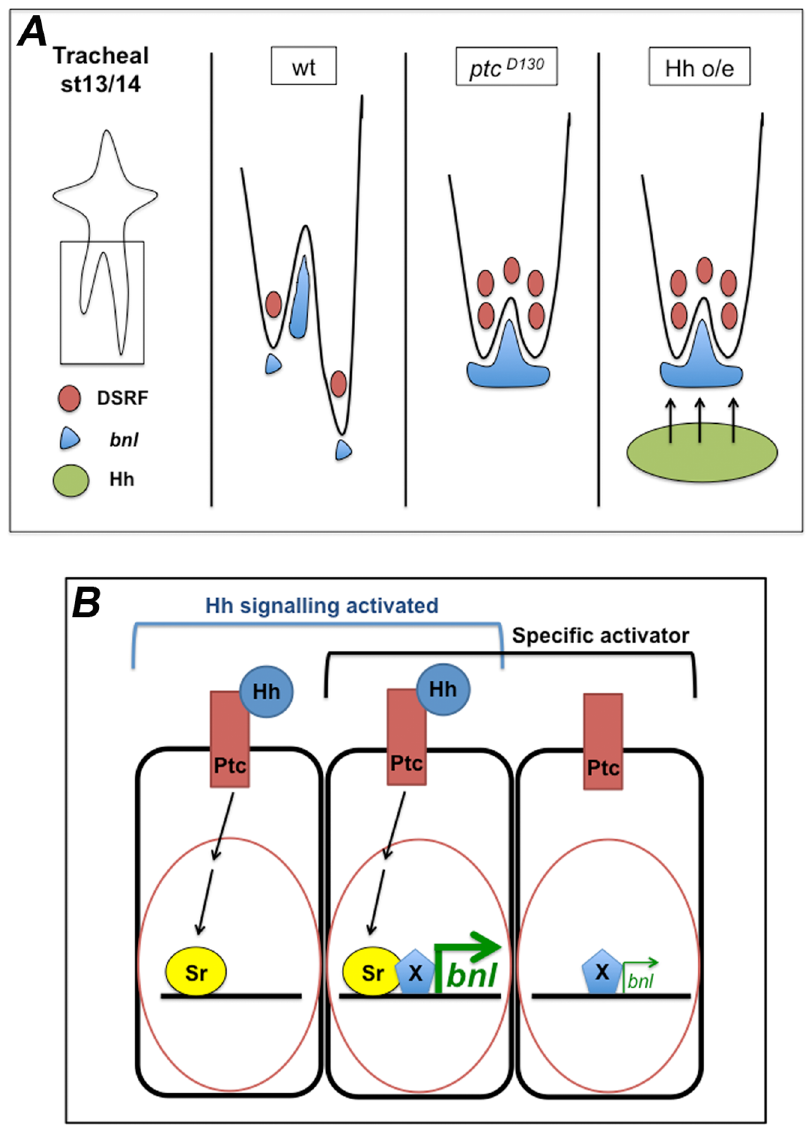
Figure 8. Proposed model of the role of Hh signalling in the regulation of bnl expression. (A) Model of changes in bnl expression dependent on Hh signalling in cells surrounding the tracheal tip-cells. Drawn are the LTa and LTp/GB in the wt, ptc mutant and Hh overexpression scenarios. Both the absence of Ptc activity and overexpression of Hh in cells near the migrating LTp/GB have the same inhibitory effect on GB migration. This is due to higher levels of bnl expression induced by the Hh pathway. (B) Proposed model for the activation of bnl expression via Sr and a cell/tissue-specific co-activator. When Hh signalling is active, SrB is one of its target genes being expressed in ptc -expressing cells. When these cells also express a specific bnl activator (X), bnl expression is induced at high levels. In the absence of Sr, X can drive bnl expression but only at low levels. The activation of the Hh pathway in addition to the expression of specific local activators is responsible for the fast upregulation of bnl expression in the tissues surrounding the migrating tracheal cells. According to this model, Sr is involved in the positive regulation of bnl expression in a permissive mode.